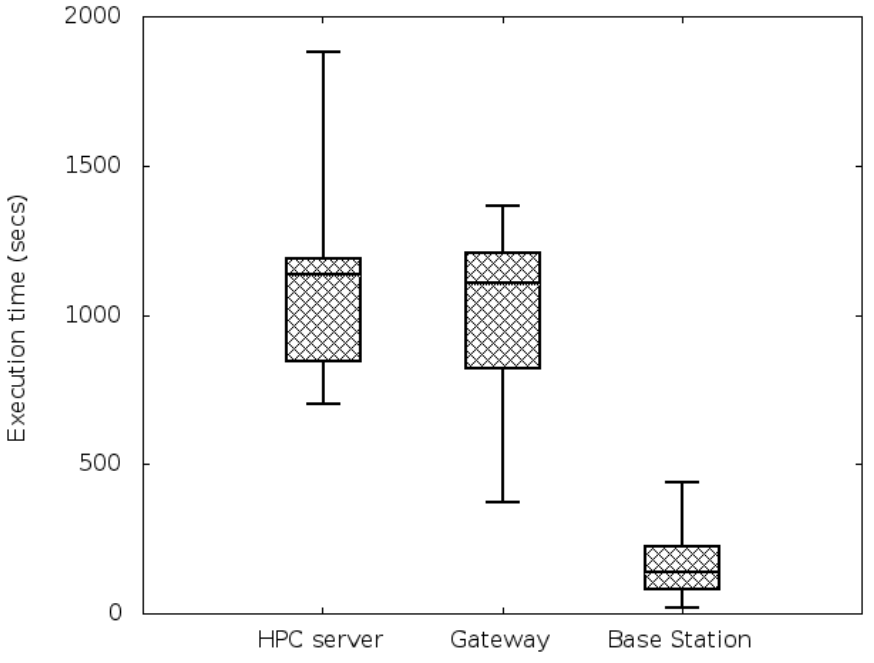
Figure 9. Execution time (in seconds) for tasks in their